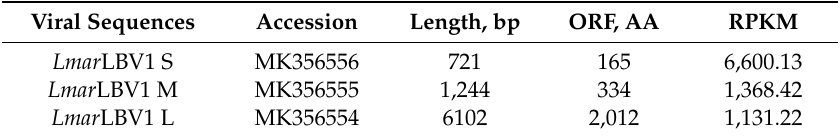
Figure 1. ( A ) Screening of double-stranded RNAs (dsRNAs) in Leishmania ( Mundinia ) spp. M, GeneRuler 1-kb DNA ladder. Indicated sizes are in kilobases: 1, L. ( M. ) martiniquensis MHOM / MQ / 92 / MAR1; 2, L. ( M. ) enriettii MCAV / BR / 45 / LV90; 3, L. ( M. ) macropodum MMAC / AU / 2004 / AM-2004; 4, L. ( M .) orientalis MHOM / TH / 2007 / PCM2. ( B ) Negative-stain transmission electron micrographs of the virus particle isolated from L. ( M. ) martiniquensis . Scale bar is 100 nm. Table 1. Molecular data for the identified RNA sequences 1 .